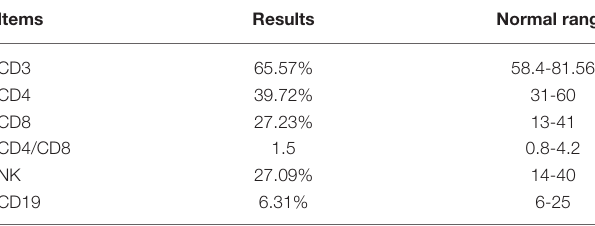
TABLE 1 | Lymphocyte subsets analysis.